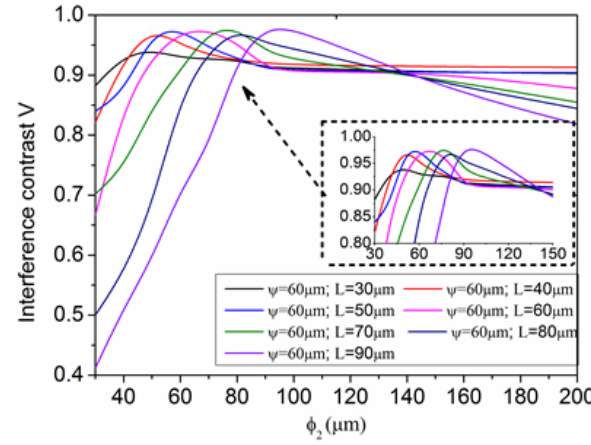
Figure 6. The curve of the microcavity interference spectrum contrast.